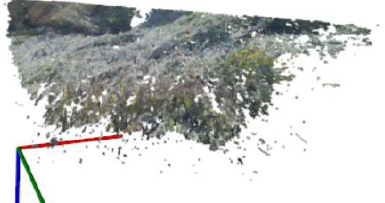
Figure 10. Initial point cloud.